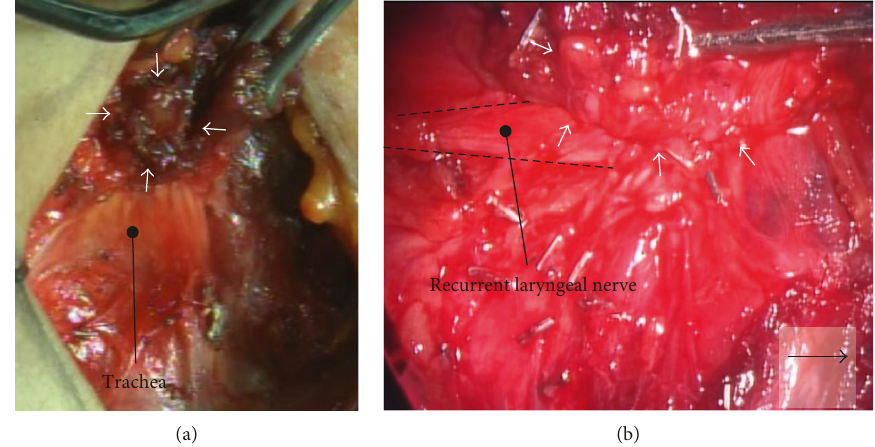
Figure 2: Surgical findings. The left lobe of the thyroid is absent. Tumor is observed on the side of the absent thyroid and has invaded the lateral branch of the recurrent laryngeal nerve. No abnormalities in the path of the recurrent laryngeal nerve are observed. Arrowheads indicate tumor; arrow indicates